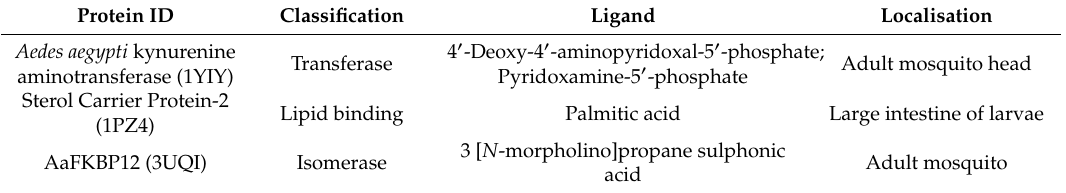
Table 2. Information about the target proteins of A. aegypti and their respective ligand.